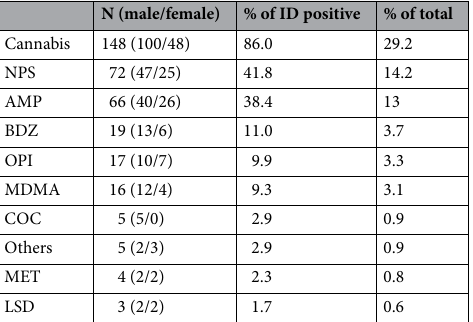
N (male/female) % of ID positive % of